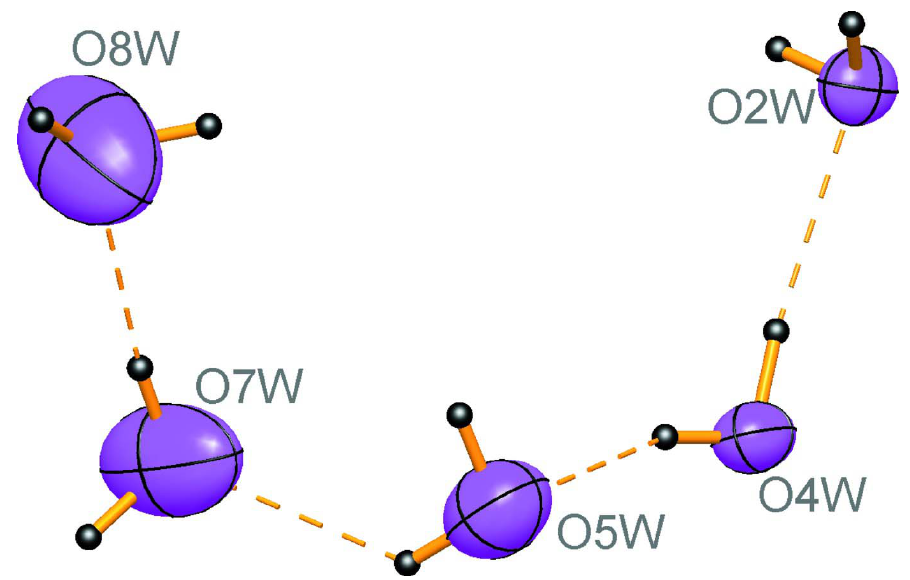
Figure 3 A view of discrete hydrogen-bonded (dashed lines) water pentamers. Displacement ellipsoids are drawn at the 50% probability